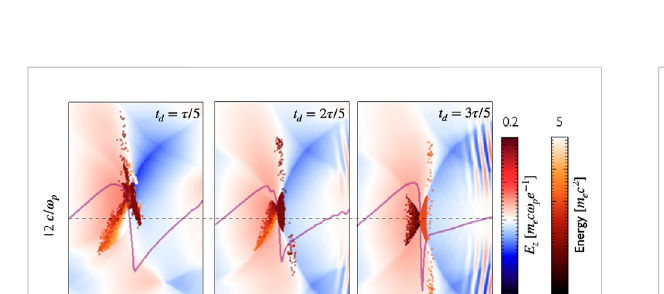
FIGURE 5 OSIRIS simulation result illustrating accelerating fi elds E z with axial shift (in y -direction) of maximum, depending on LG mode displacement. Transverse slice ( zy -plane) of the electric fi eld E z in red-blue, lineout along maximum of E z in purple and electrons with p z > 2 m e c in hot colors depending on energy. (a) Scenario with strong overlap of LG modes with t d = τ /5, (b) scenario with medium overlap of LG modes with t d = 2 τ /5, (c) scenario with small overlap of LG modes with t d = 3 τ /5.